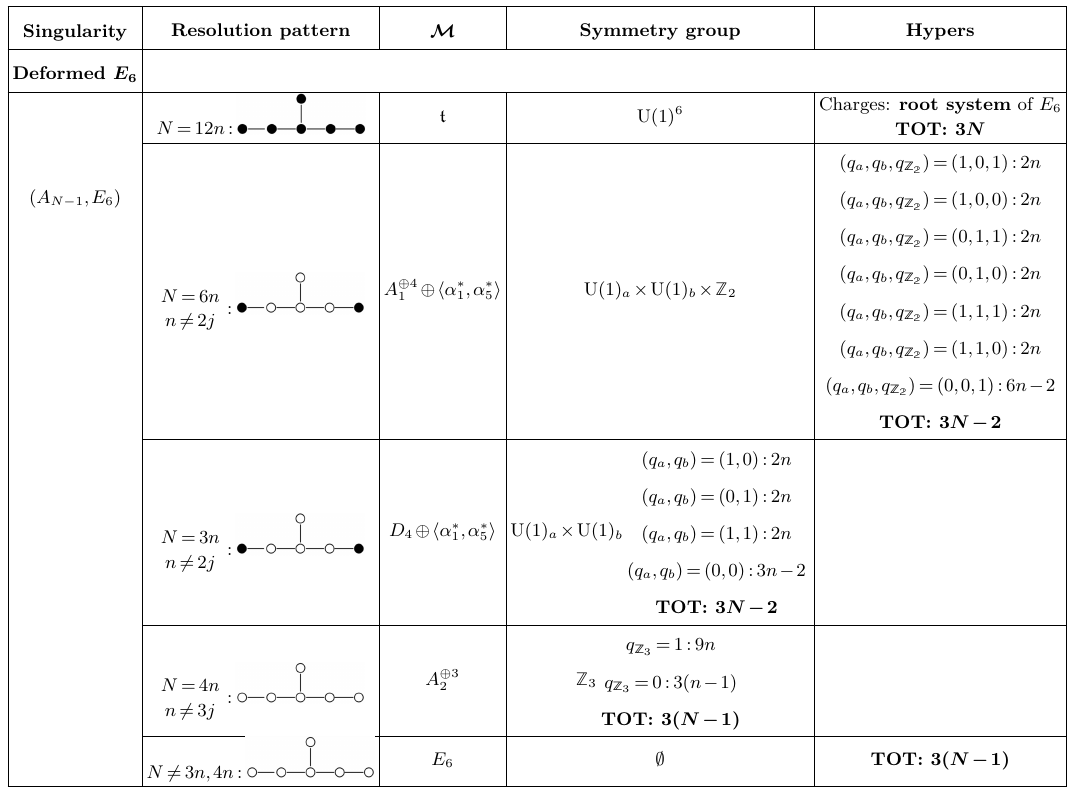
Table 5 . Higgs branch data for quasi-homogeneous cDV singularities of ( A N − 1 , E 6 )